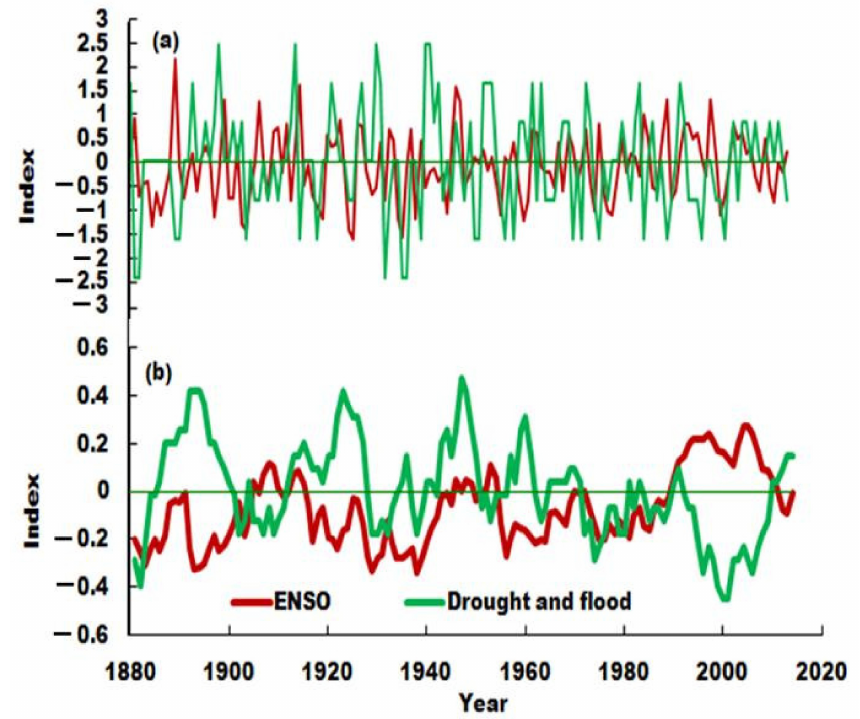
Figure 10. Comparison of ENSO and drought and flood index. ( a ): original sequence; ( b ): 15 years sliding